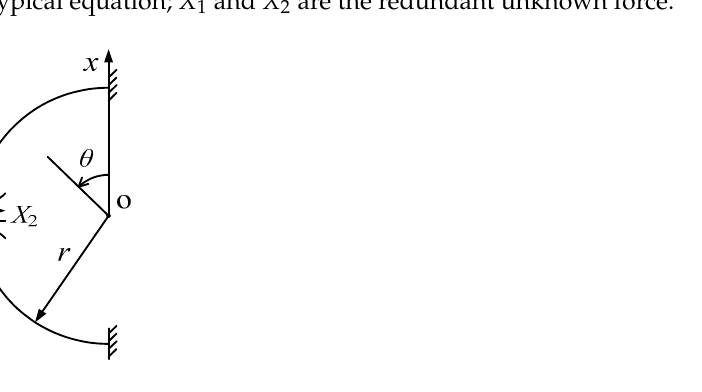
Figure 1. Diagram of internal load in the section of pressurized water conveyance tunnel.